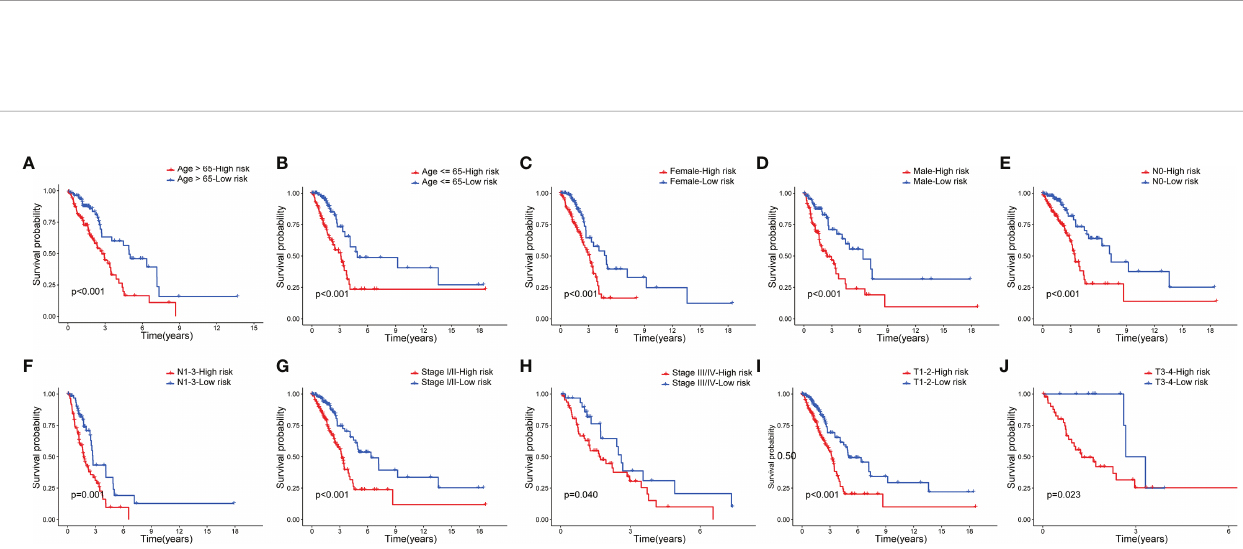
FIGURE 6 | Survival analysis of clinical strati fi cation of OS in the TCGA cohort. (A, B) age (< = 65 or > 65 years old). (C, D) gender (female or male). (E, F) N (N0 or N1-3). (G, H) tumor stage (I – II or III-IV). (I, J) T (T1-2 or